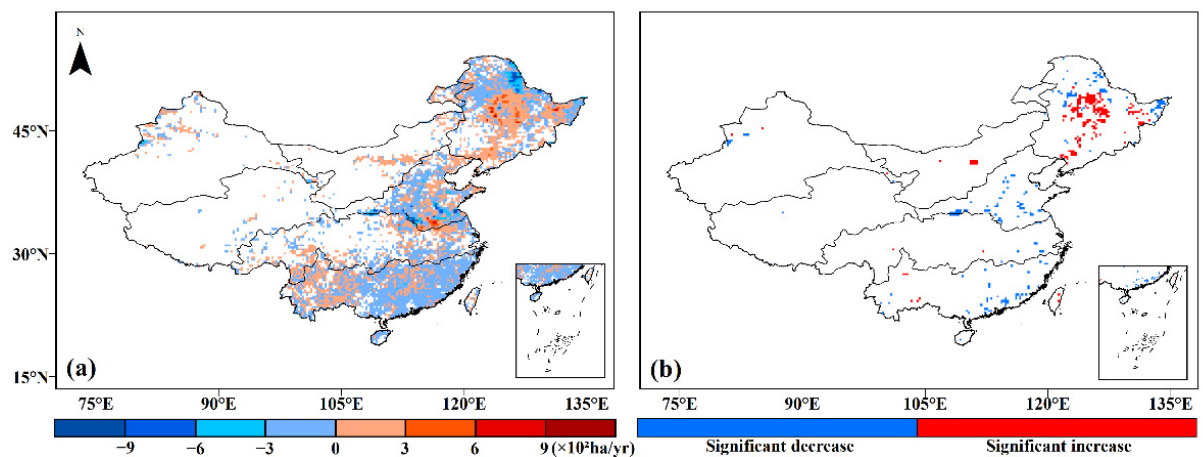
Figure 9. Spatial distribution of annual BA trends: ( a ) the trends of all fire points, where a positive value (red) indicates an increasing trend and a negative value (blue) indicates a decreasing trend; ( b ) the trends of the points passing the significance test ( p < 0.1).